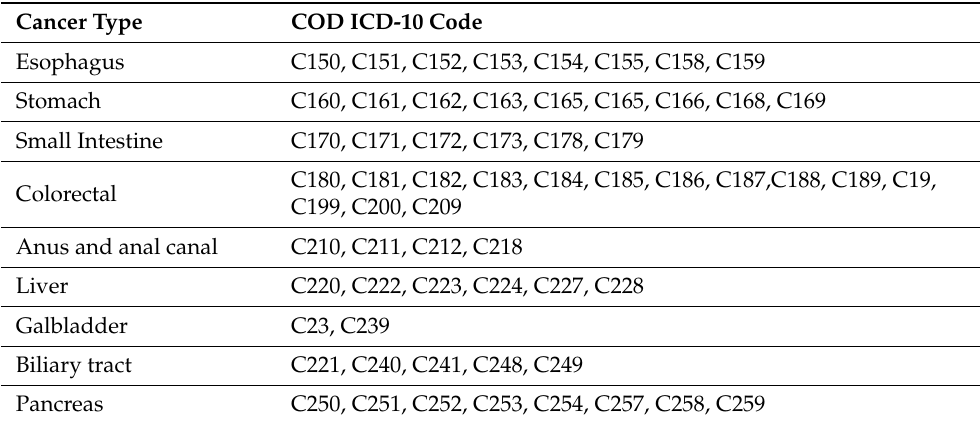
Table A1. GI Cancer Cause of Death